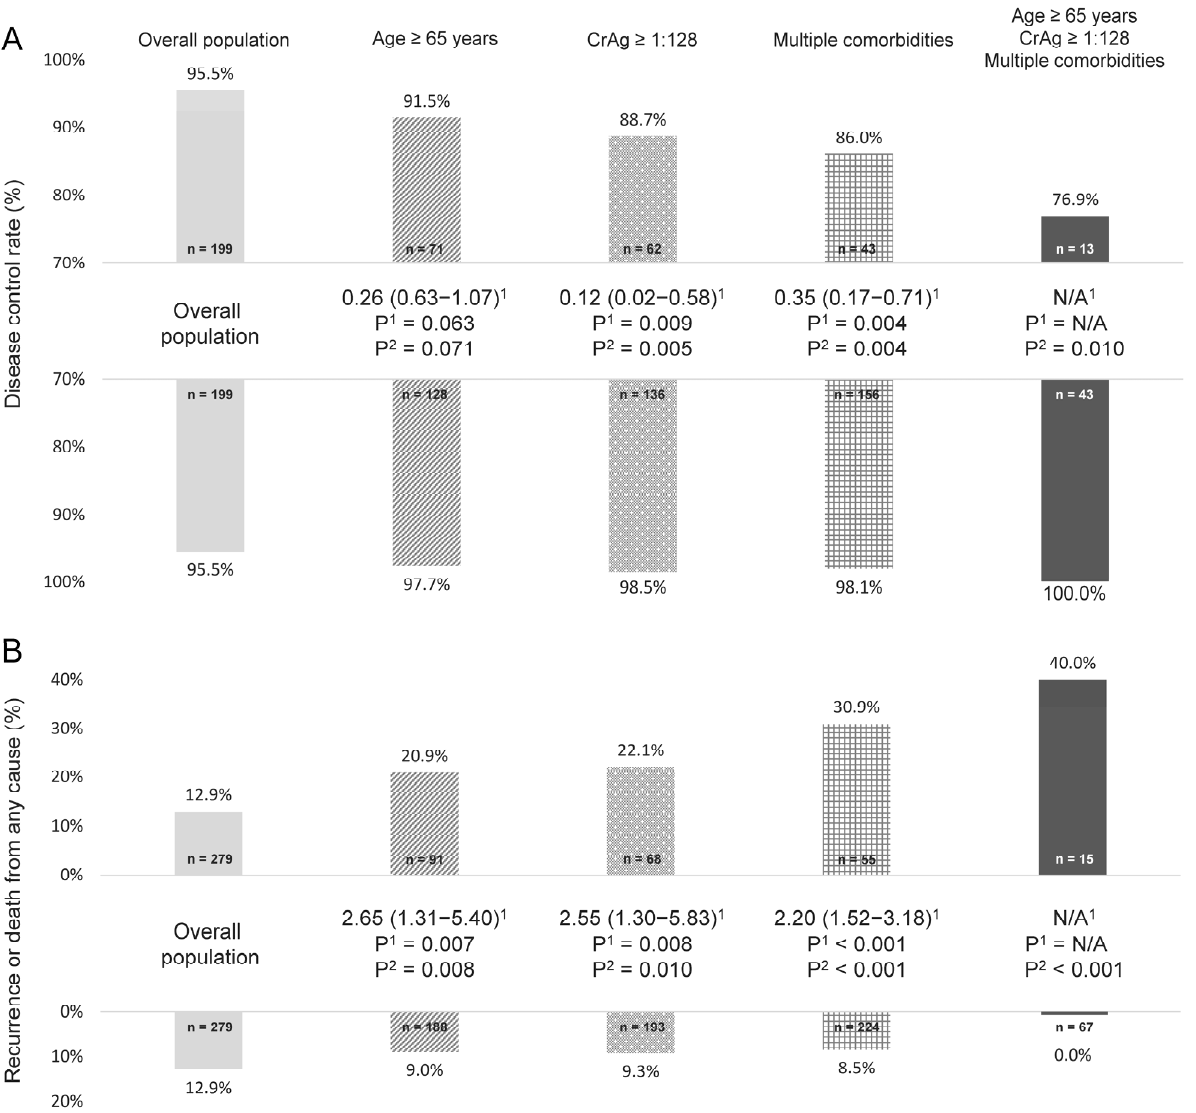
Figure 1. Age, cryptococcal antigen (CrAg) test of blood, comorbidities, and their association with the outcome of isolated pulmonary cryptococcosis: disease control rate ( A ) and recurrence or death from any cause ( B ). 1 By logistic regression analysis and data were presented as odds ratio (95% confidence interval). 2 By Fisher’s exact test. Upper bars denoted “with” and lower denoted “without” the preset condition(s) for analysis. N/A, not applicable.